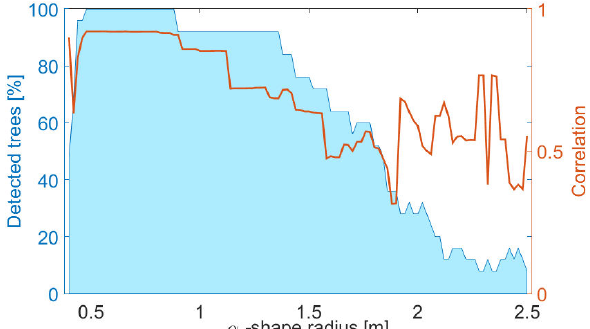
Figure 3. R value impact on percentage of detected trees and correlation coefficient between estimated and measured tree geometric